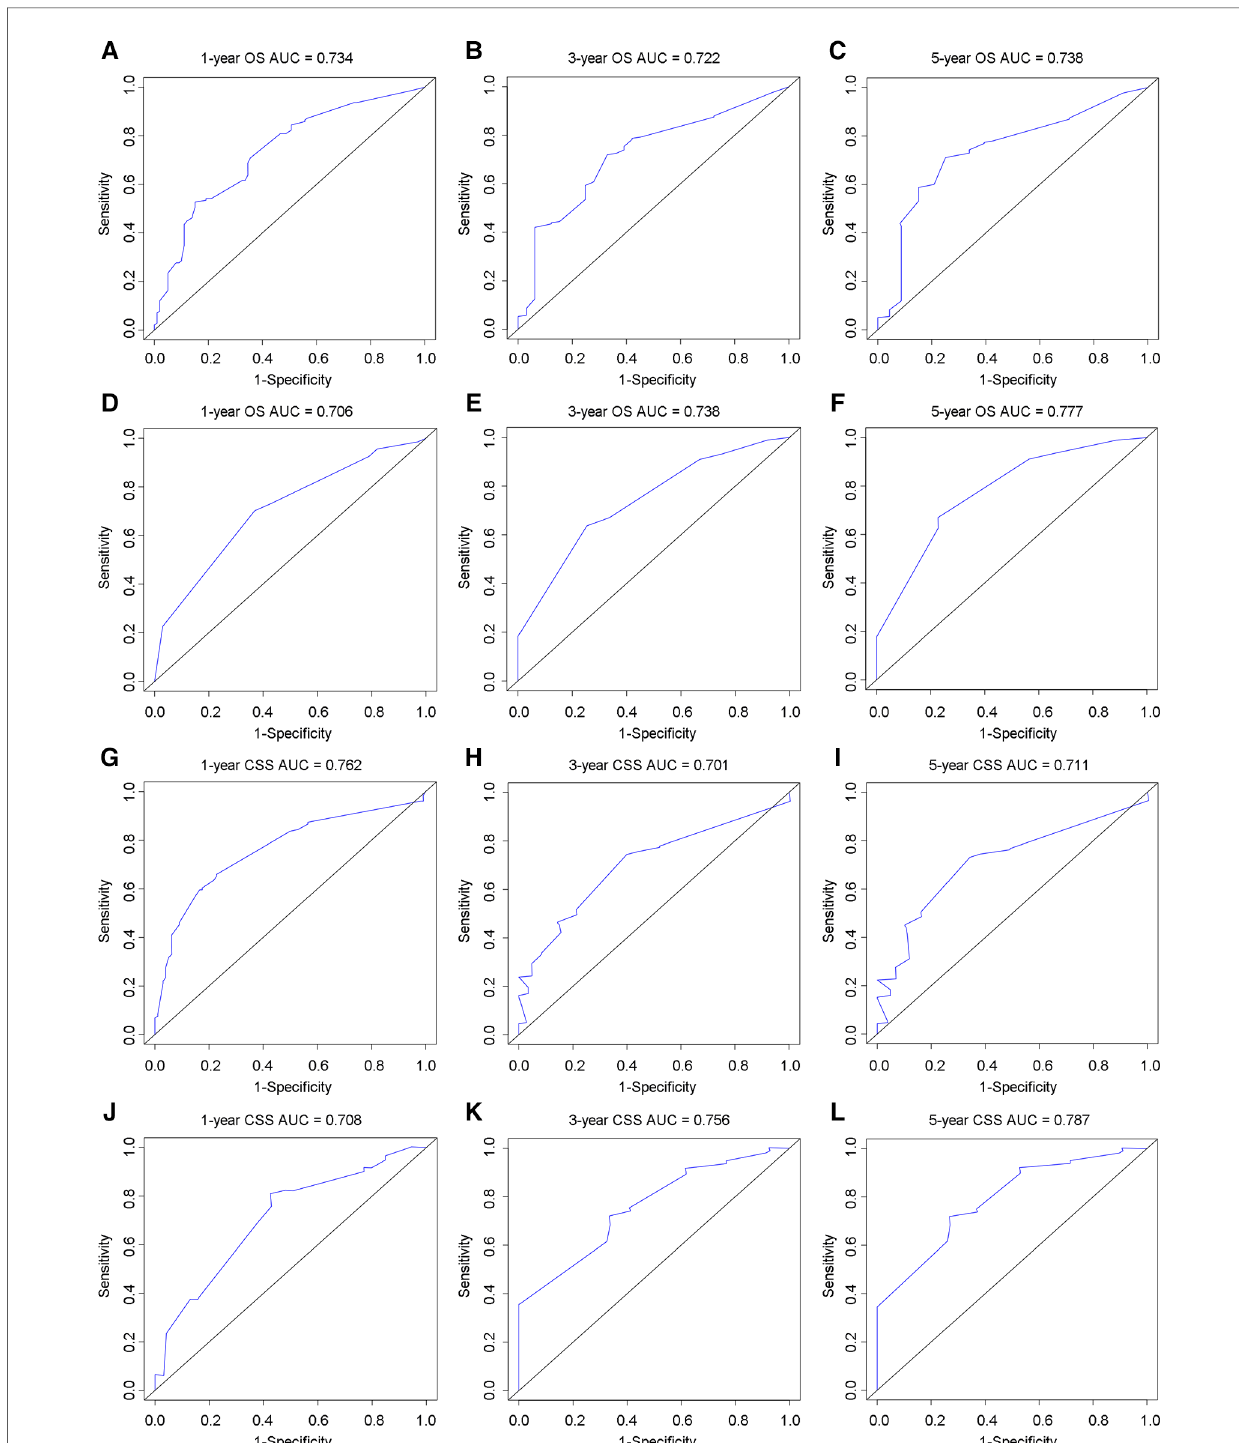
FIGURE 3 ROC curves to analyze the accuracy of the nomogram for 1-, 3-, and 5-year OS and CSS. ROC for OS at 1-year ( A ), 3-year ( B ), 5-year ( C ) in training group; ROC for OS at 1-year ( D ), 3-year ( E ), 5-year ( F ) in validation group; ROC for CSS at 1-year ( G ), 3-year ( H ), 5-year ( I ) in training group; ROC for CSS at 1-year ( J ), 3-year ( K ), 5-year ( L ) in validation